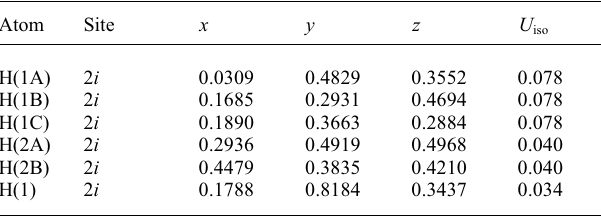
Table 2. Atomic coordinates and displacement parameters (in Å 2 )